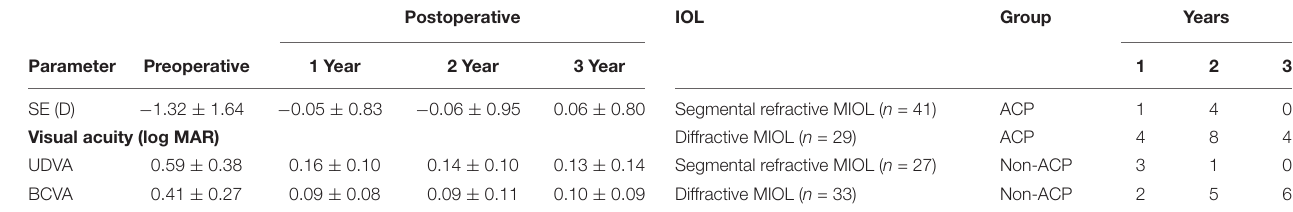
TABLE 5 | Neodymium: YAG laser capsulotomies performed in the 3-year follow-up examination.